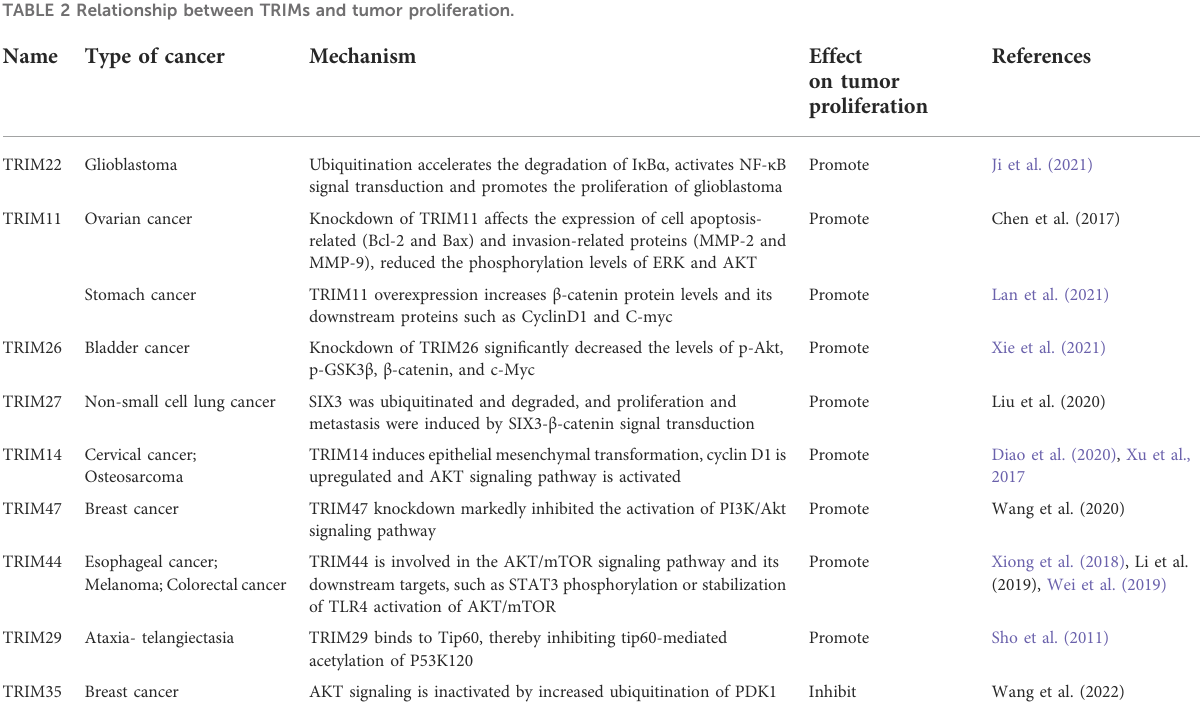
TABLE 2 Relationship between TRIMs and tumor